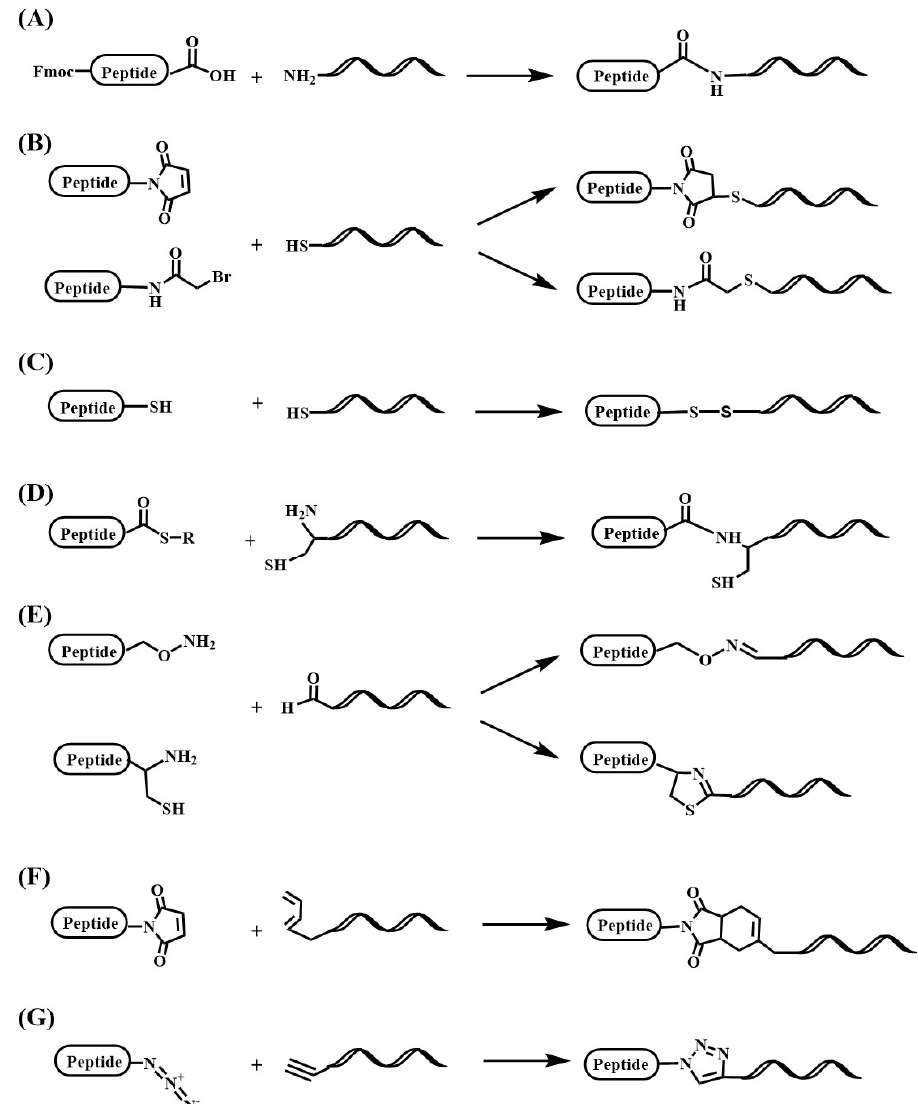
Figure 5. Postsynthetic reactions for the synthesis of oligonucleotide-peptide conjugates. ( A ) Using protected peptide segments for fragment condensation [175], ( B ) thiol-maleimido and thiol-bromoacetamido reactions [176], ( C ) disulfide formation [177–179], ( D ) synthesis by native ligation [180], ( E ) oximes or thiozolidine reactions [181–183], ( F ) conjugation by Diels-Alder reaction [184,185], ( G ) conjugation reactions catalyzed by copper to produce alkyne-azide cyclo additions [186–188].